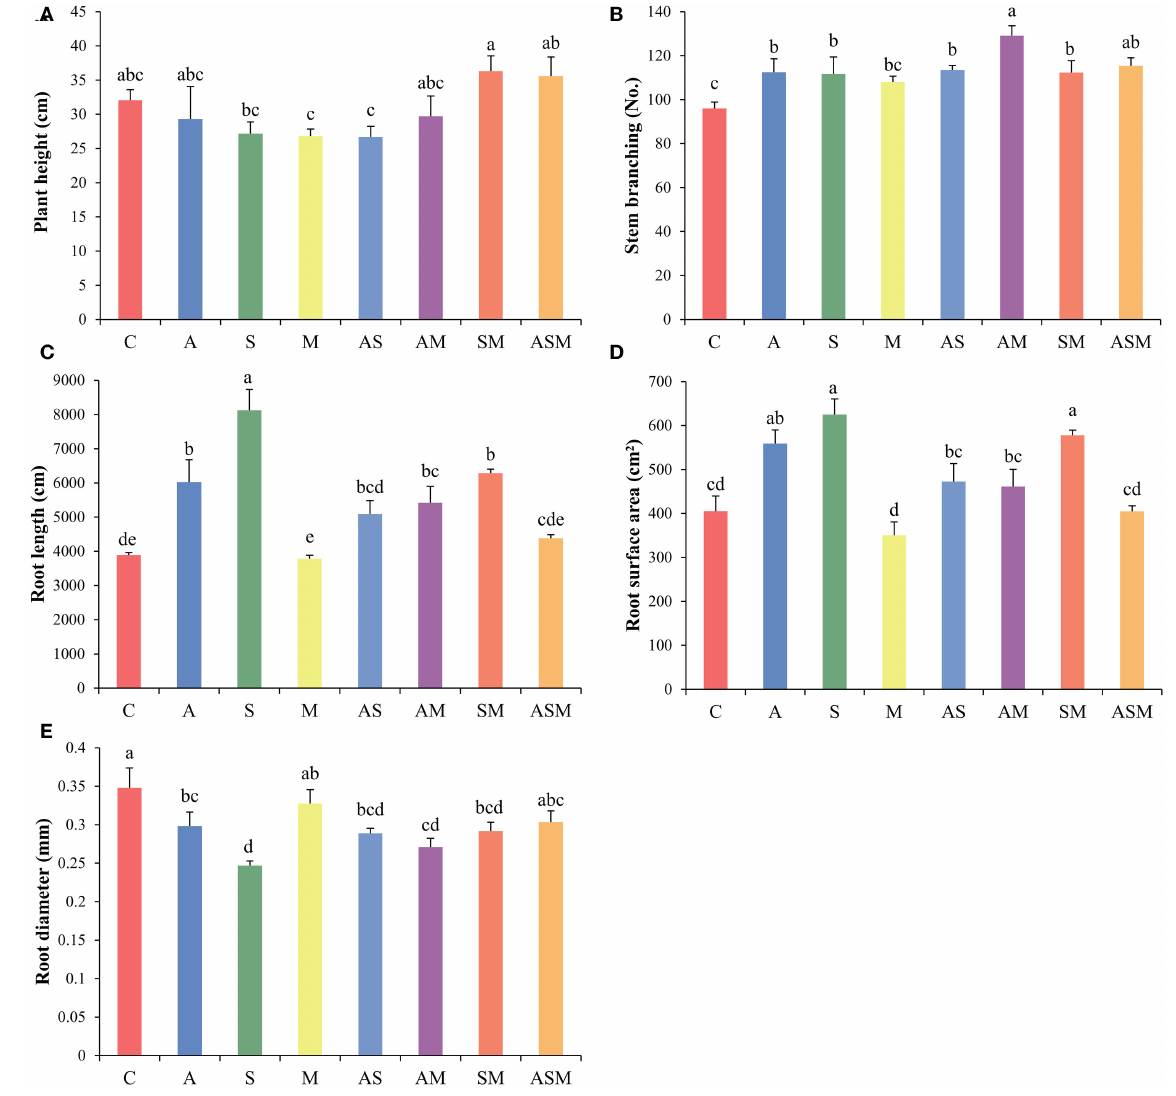
FIGURE2 Effects of combined inoculation effects of root endophytic fungi on the morphological parameters of A. adsurgens seedlings. (A) Plant height, (B) stem branching, (C) root length, (D) root surface area, and (E) root diameter. Different lowercase letters indicate significant differences ( p < 0.05). C, non-inoculated control; A, inoculation with Alternaria chlamydospora ; S, inoculation with Sarocladium kiliense ; M, inoculation with Monosporascus sp .; AS, co-inoculation of Alternaria chlamydospora and Sarocladium kiliense ; AM, co-inoculation of Alternaria